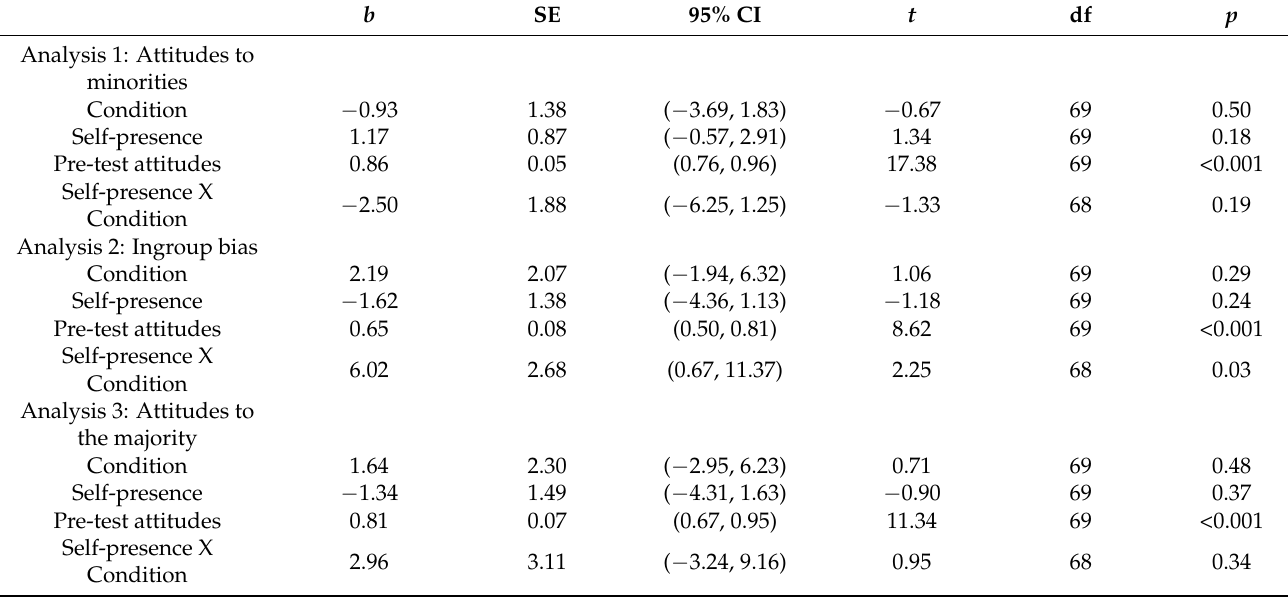
Table 1. Attitudes Regression Analyses (Study 2; n = 73).